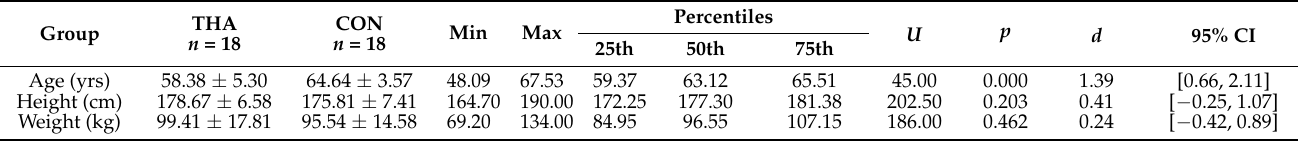
Table 1. Characteristics of the THA and CON groups.